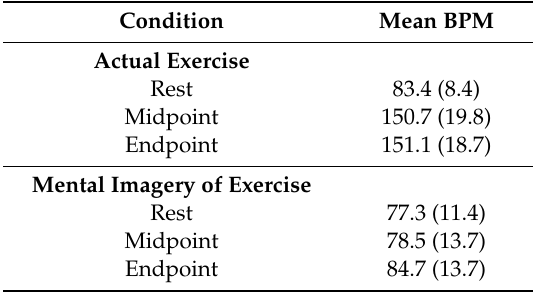
Table 2. Heart rate responses to the experimental manipulation.